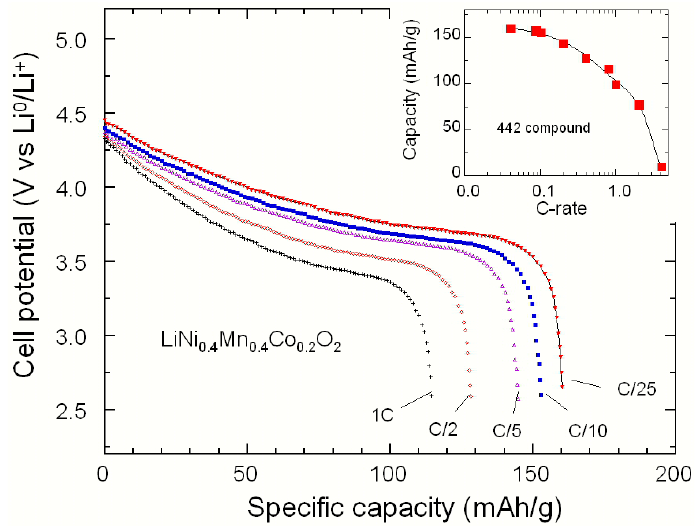
Figure 8. Discharge profiles vs. specific capacity of the Li//LiNi 0.4 Mn 0.4 Co 0.2 O 2 cells between 2.5 and 4.4 V at various C-rates. The inset shows the rate capability of the 442 compound.